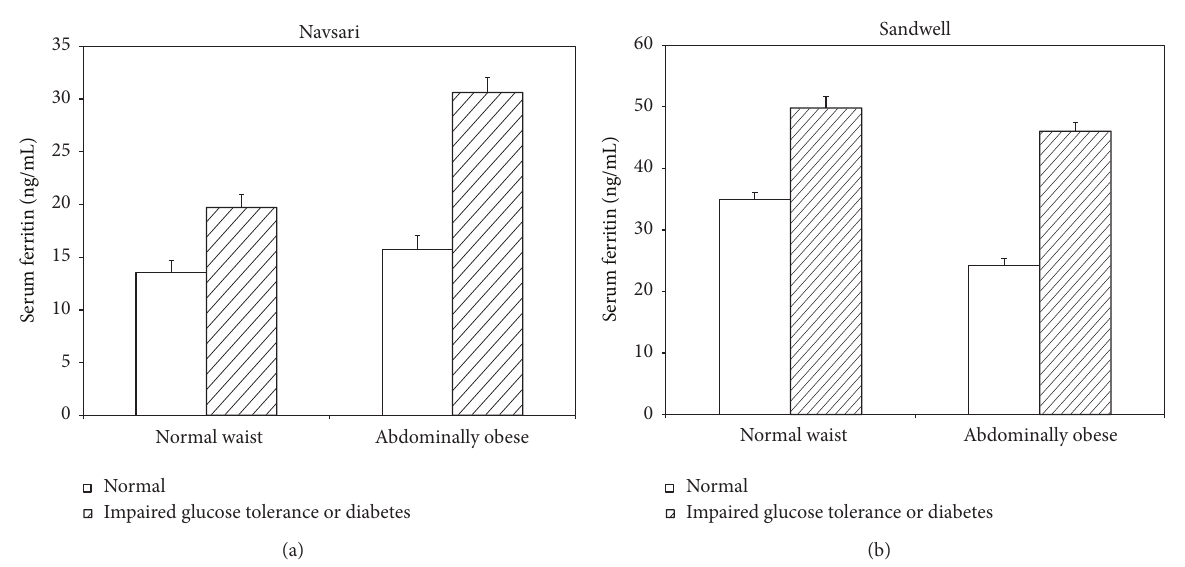
Figure 2: Bar chart of serum ferritin in nonmigrant (Navsari) and migrant (Sandwell) Indian Gujaratis by diabetes and central obesity status. Bars show geometric means (error bars show 1 standard